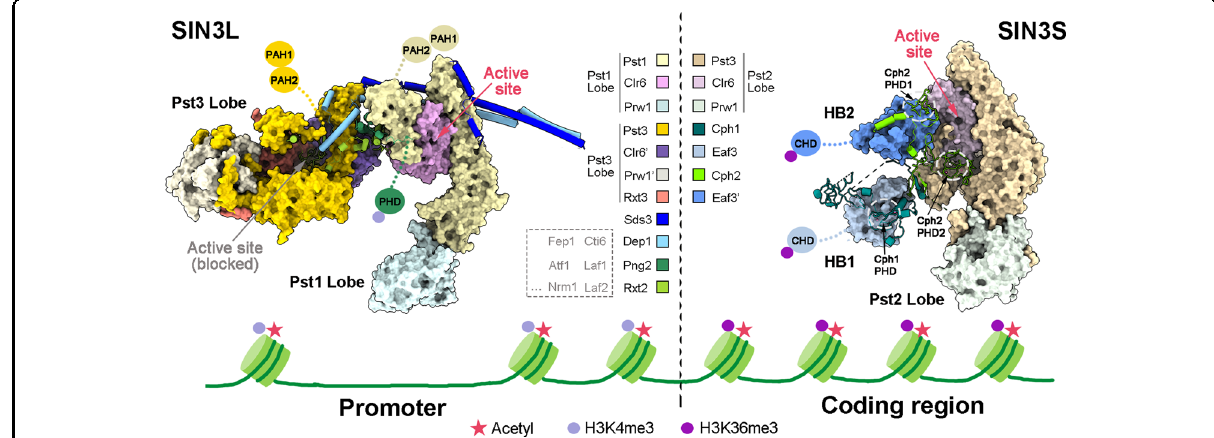
Fig. 5 Two distinct assembly modes facilitate SIN3L and SIN3S to target different chromatin regions. The model shows that SIN3L and SIN3S adopt two distinct assembly modes to target different chromatin regions. The SIN3L complex has two lobes (Pst1/3 Lobe) bridged by two coiled-coil domains from Sds3/Dep1 and Rxt2/Png2, while the SIN3S complex has only one lobe (Pst2 Lobe) and two HBs (HB1 and HB2). The Pst1 Lobe in SIN3L and the Pst2 Lobe in SIN3S have similar conformations with their deacetylase active sites exposed to the space; the Pst3 Lobe in SIN3L is in a compact state with its active center buried inside and blocked. The SIN3L complex provides several domains for chromatin recognition, such as the PAH1/2 of Pst1/3 (interacting with transcription factors), the PHD of Png2 (may recognize the H3K4me3 histone marker), the PHD of Cti6 and the SWIRM domain of Laf1/2. Different combinations of these domains may be used to recognize speci fi c promotors. The HB1 and HB2 of the SIN3S complex may offer two binding sites for the adjacent nucleosomes with H3K36me3